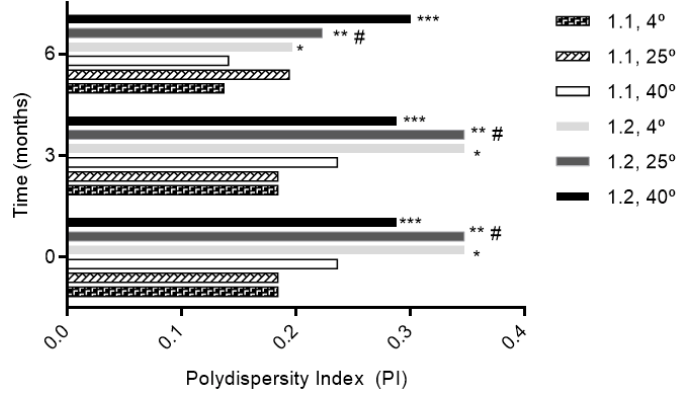
Figure 1. The influence of storage conditions of T and RH in phytosomal formulation size. **** p ˂